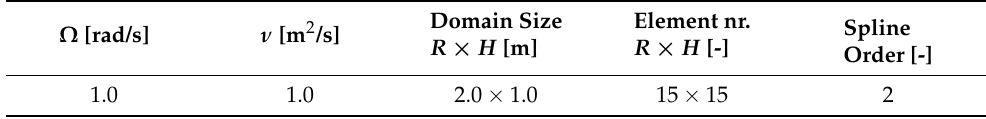
Table 3. Parameters used for the infinite rotor-stator configuration